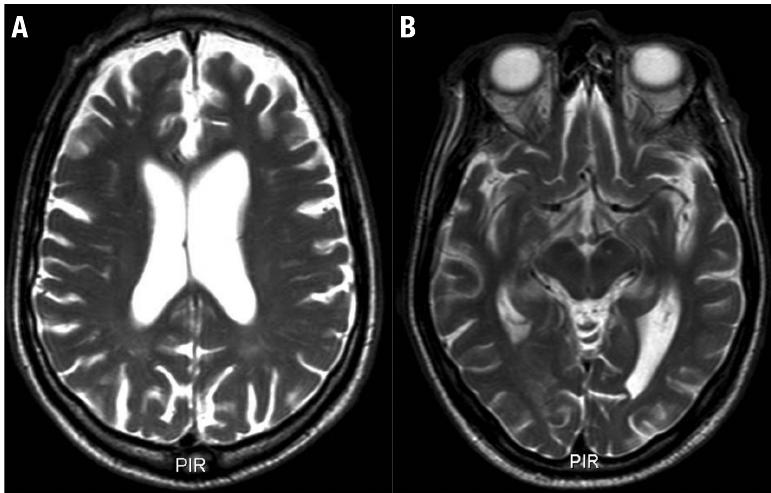
Figure 2. Brain MRI (T2-weighted axial sections) revealed: [A] moderate pre-frontal atrophy, especially in the medial and dorsolateral areas and asymmetric ventricular dilatation (greater in the left hemisphere); [B] asymmetric atrophy (greater in the left